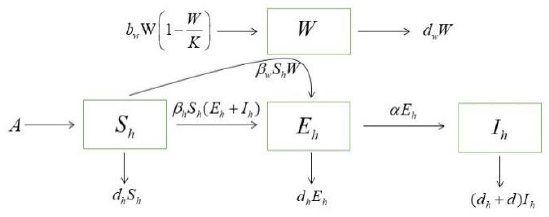
Figure 1. Transforming relationships with direct transmission.